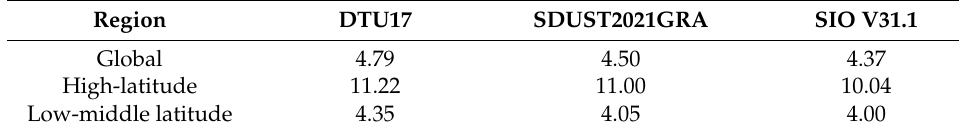
Table 3. The RMS of the gravity model in different regions (Unit: mGal).